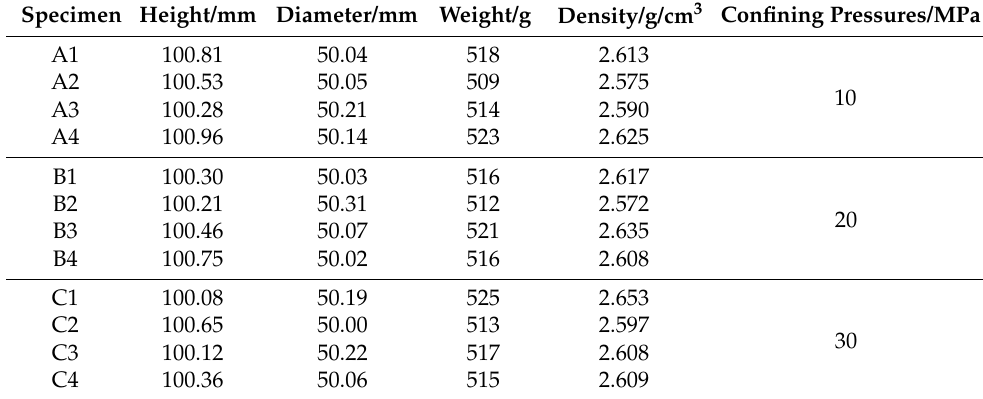
Table 1. Mechanical parameters of deep granites.